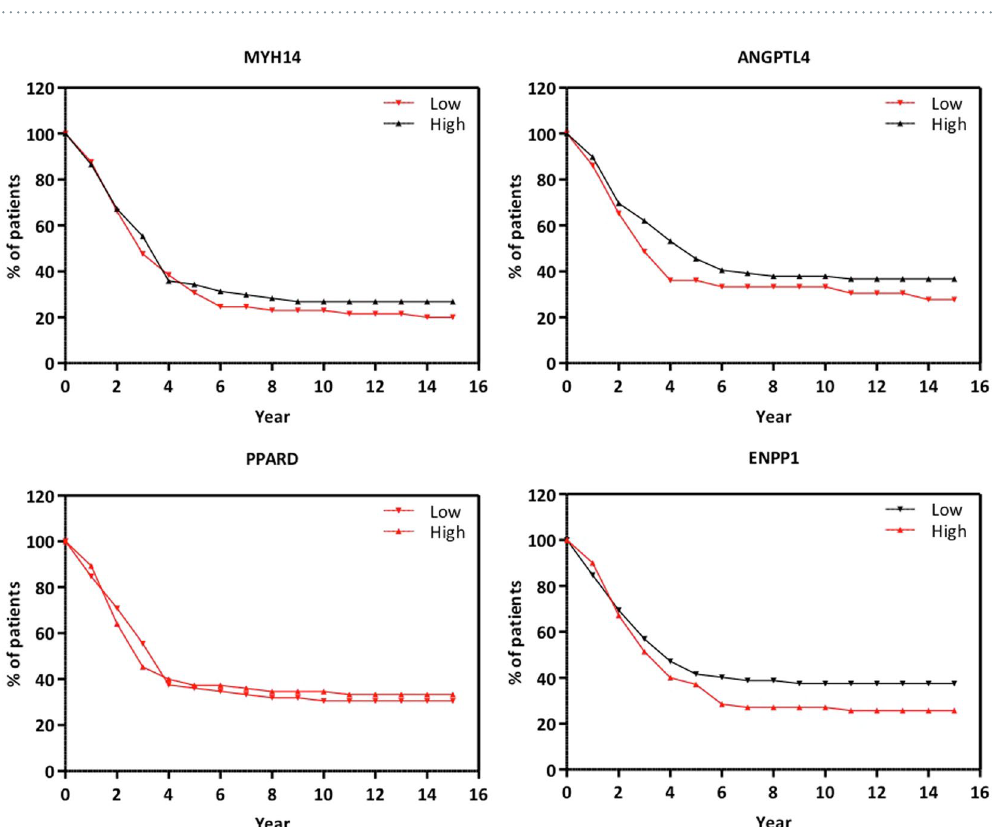
Figure 6. Clinical data of head and neck cancer from TCGA (n = 248), relative to proposed molecular targets. Low expression of ( A ) MYH14 and ( B ) ANGPTL4 (red line) and high expression (black line); ( C ) low and high expression (red lines) of PPARD; and high (red line) and low expression (black line) of ENPP1, in alive patients. Dotted gray lines represent gene expression of dead